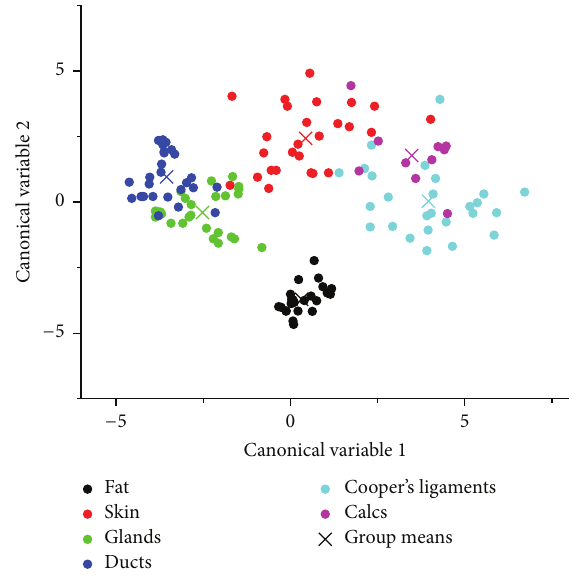
Figure 10: Results of the statistical linear discriminant analysis (LDA) classification based on the three QT Ultrasound features (speed of sound, attenuation, and reflection). The plot shows the projection of the data points onto the two-dimensional discriminant score space.